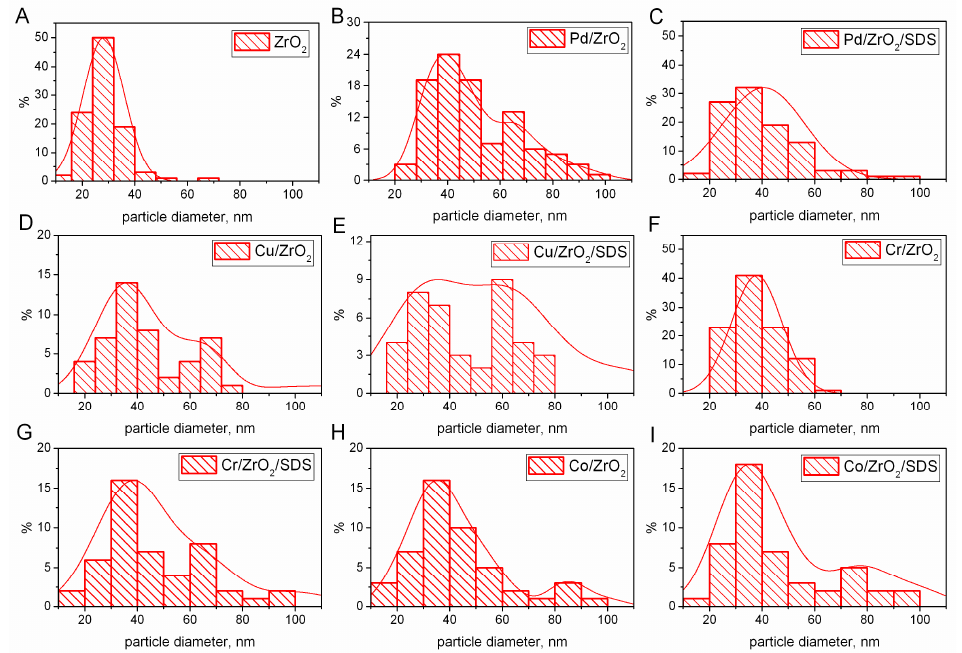
Figure 1. Particle size distribution histograms from analysis of TEM micrographs: ( A ) ZrO 2 ; ( B ) Pd/ZrO 2 ; ( C ) Pd/ZrO 2 /SDS; ( D ) Cu/ZrO 2 ; ( E ) Cu/ZrO 2 /SDS; ( F ) Cr/ZrO 2 ; ( G ) Cr/ZrO 2 /SDS; ( H ) Co/ZrO 2 ; ( I ) Co/ZrO 2 /SDS; corresponding TEM micrographs presented in Supplementary Materials in Figure S1.